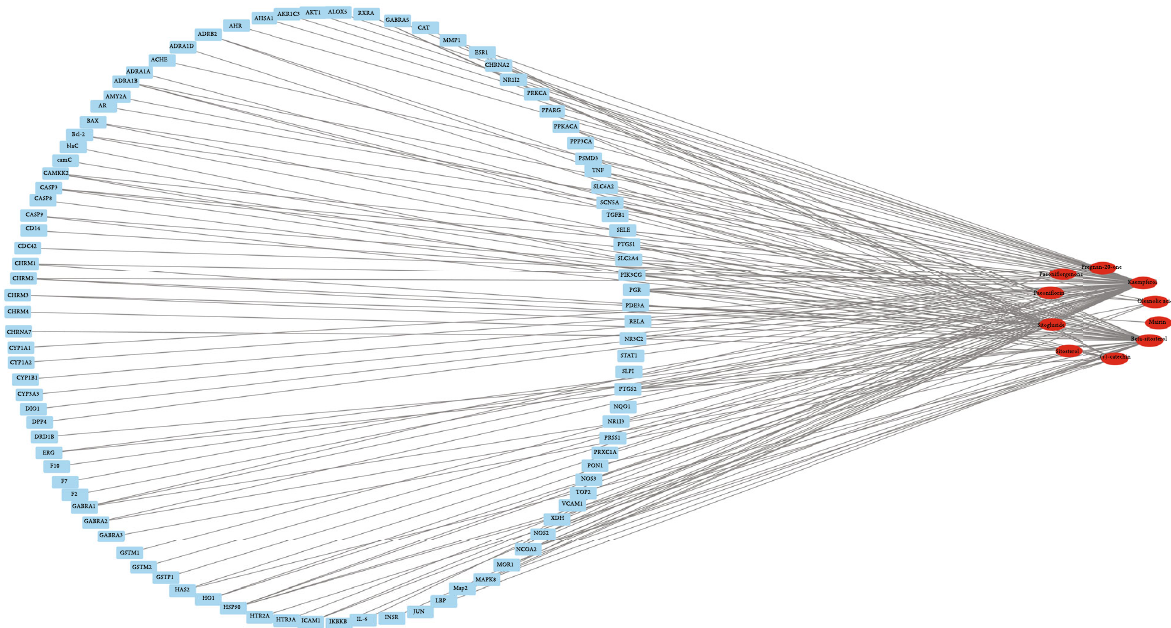
Figure 1: Part of main active ingredients of PRA.